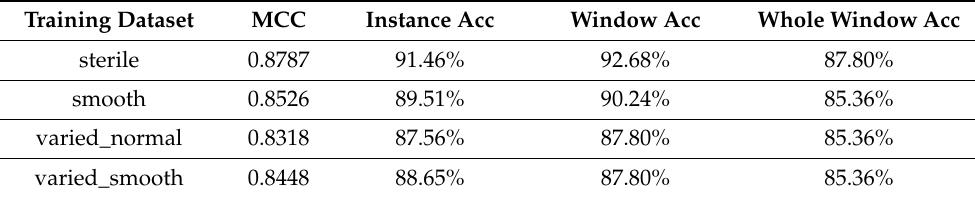
Table 5. Results of the best-performing model on the real-world dataset without the results for B, E, F, and G classes.